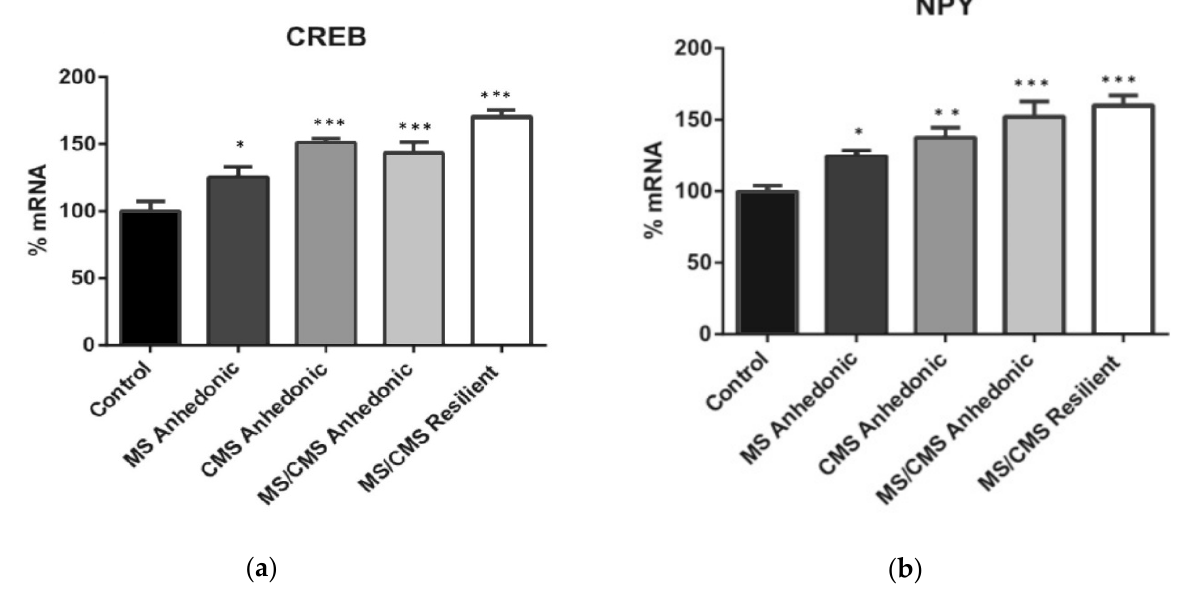
Figure 3. Expression of the transcription factor CREB ( a ) and of neuropeptide Y (NPY) ( b ). CREB ( a ): control vs. MS anhedonic * = p < 0.05; control vs. CMS anhedonic *** = p < 0.001; MS/CMS anhedonic vs. MS/CMS resilient * = p < 0.05; NPY ( b ): control vs. MS anhedonic * = p < 0.05; control vs. CMS anhedonic ** = p < 0.01. Data shown as mean fold change expression +/ − SEM.